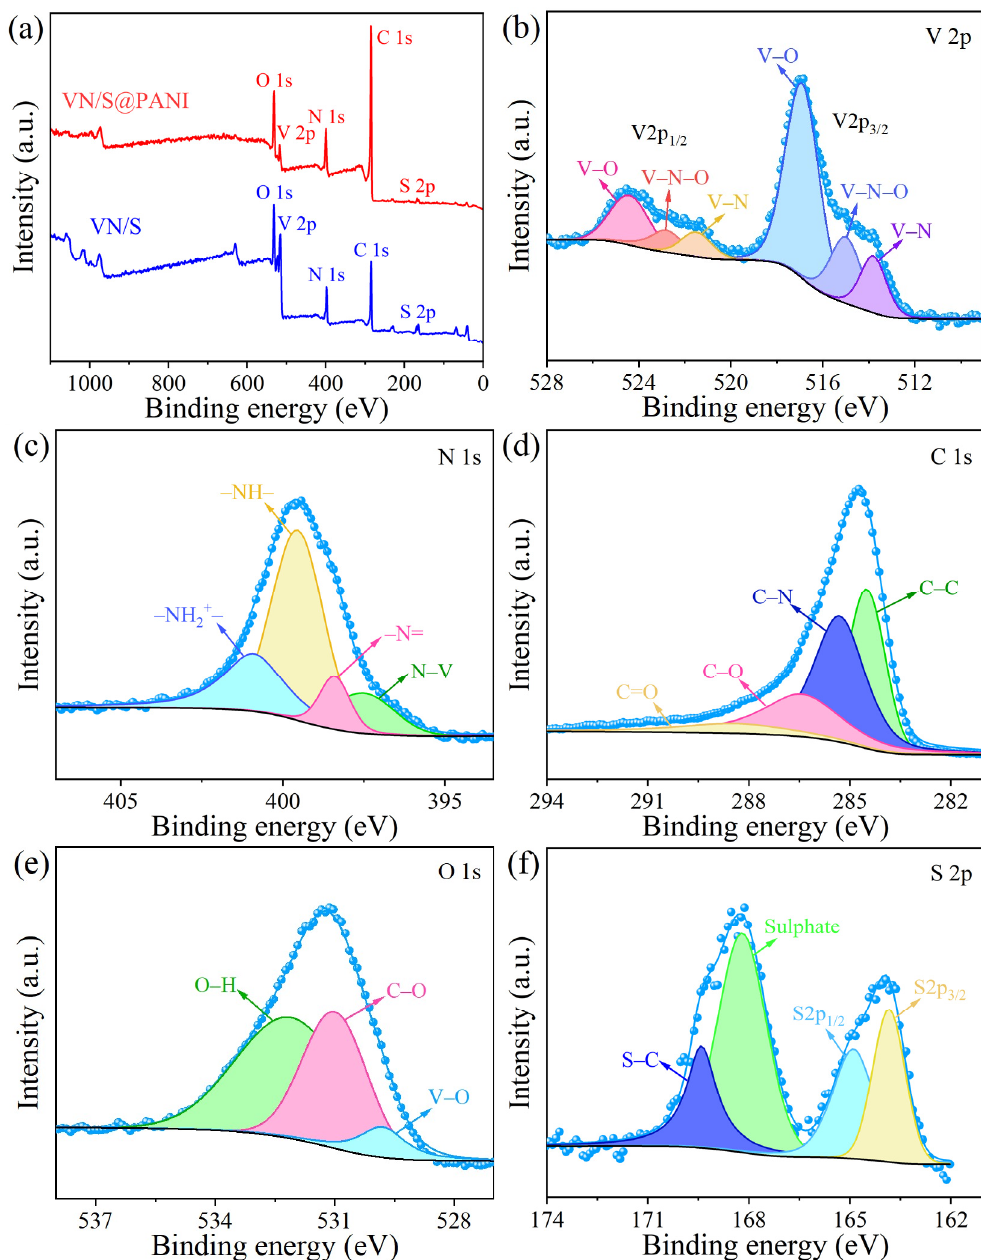
Figure 6. XPS spectra of VN/S@PANI microrods: ( a ) full survey spectrum, ( b ) V 2p, ( c ) N 1s, ( d ) C 1s, ( e ) O 1s, and ( f ) S 2p spectra.